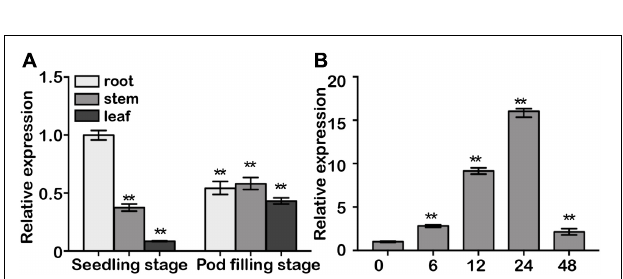
FIGURE 2 | Gene expression analysis of GmDAD1 . (A) GmDAD1 mRNA levels in various tissues of soybean cultivar Williams. Leaves, roots, and stems were harvested from plants at the seedling and pod filling stage. (B) Expression profiles of GmDAD1 in Williams (compatible interaction) at 0, 6, 12, 24, 48 h post inoculation (hpi) with P. sojae (P6497). The relative expression level was normalized to soybean GmCons4 (GenBank: BU578186.1). Means and standard deviations were calculated from three independent biological replicates. Data were analyzed by using Student’s t -tests ( ∗∗ P <